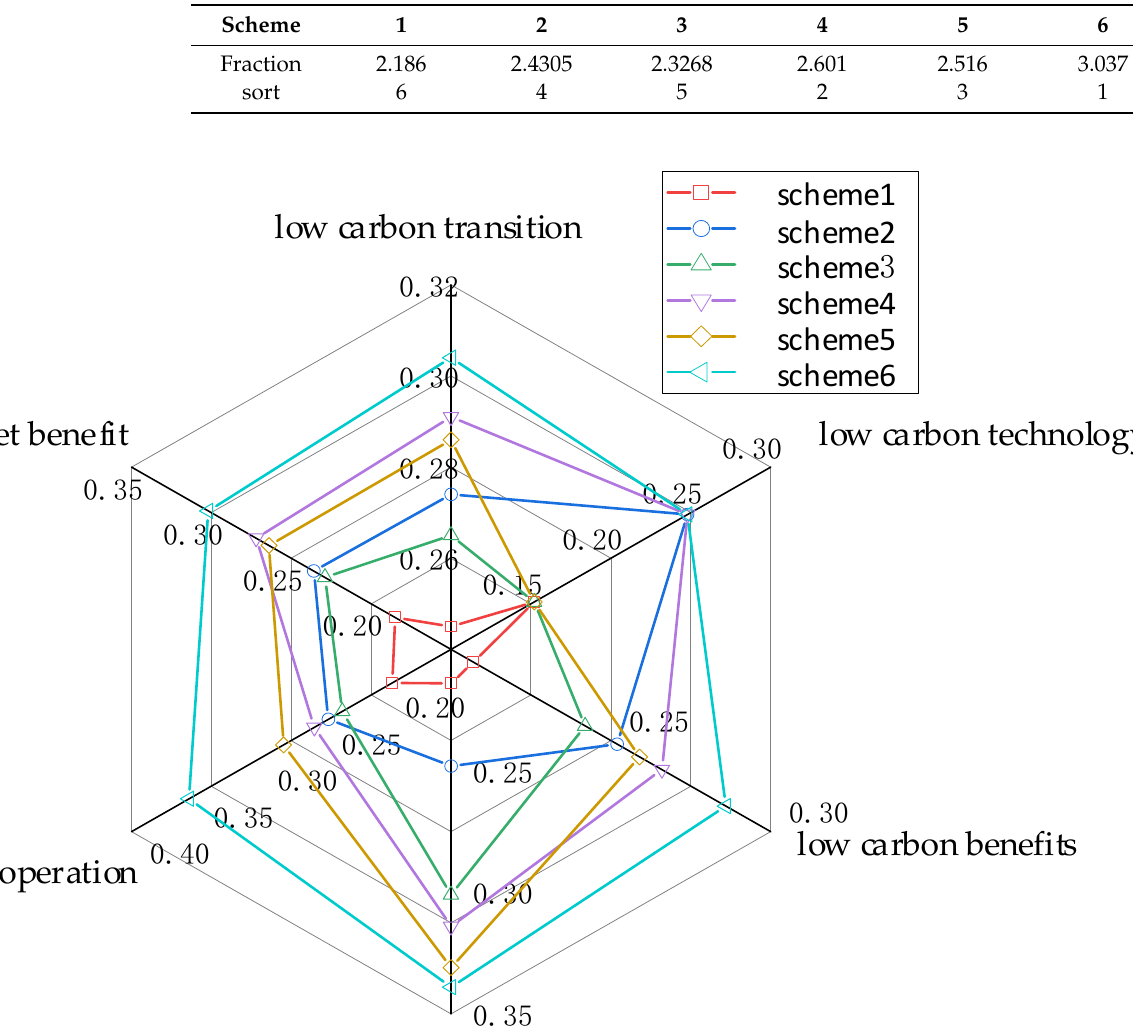
Table 6. Valuation results and ranking.